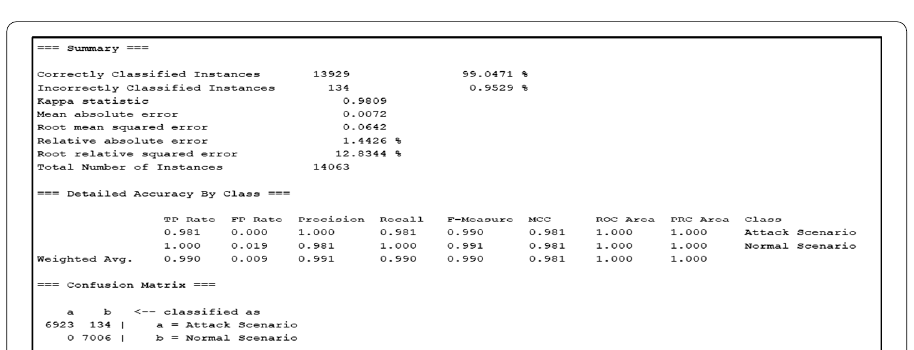
Fig. 6 Detailed Accuracy for Training Dataset using Naive Bayes Machine Learning